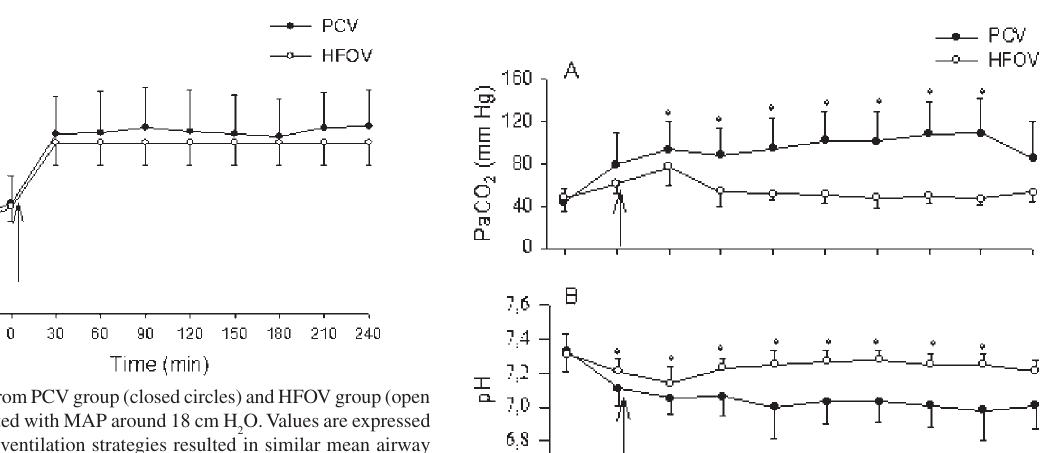
O. Values are expressed 2 Figure 3 - Group mean±SD are shown for PCV group (close circles) and HFOV group (open circles). “Initial” time are values before lung lavage; “zero” time corresponds to values immediately after the installation of the experimental model. The arrow indicates the moment of LIP determination and beginning of both ventilatory strategies. Panel A : PaCO protective ventilatory approach adopted, the PaCO among animals from PCV group; Panel B : pH. Significant decrease